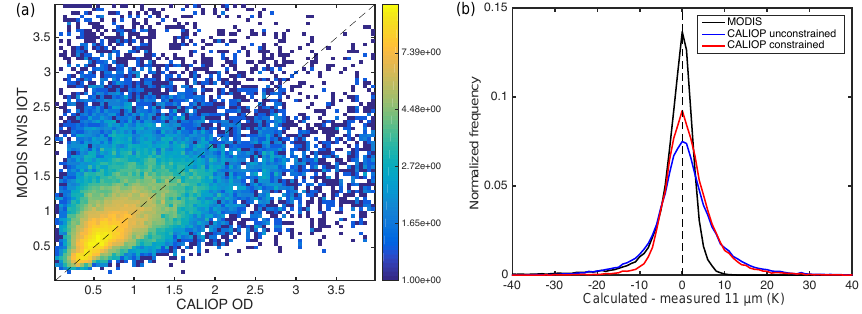
Figure 10. The CALIOP unconstrained IOT but processed using a modified lidar ratio of 32 is compared to the new single-habit ice scattering lookup table used in the updated MODIS C6 IOT retrievals in (a) . Note the improved bias relative to the MODIS C5 and V3 CALIOP retrievals presented in Fig. 1. The radiative closure analysis using the updated retrievals is presented in (b) . The modifications have greatly improved agreement with the measured MODIS 11µm channel compared to MODIS C5 and the current V3 CALIOP retrievals presented in Fig.